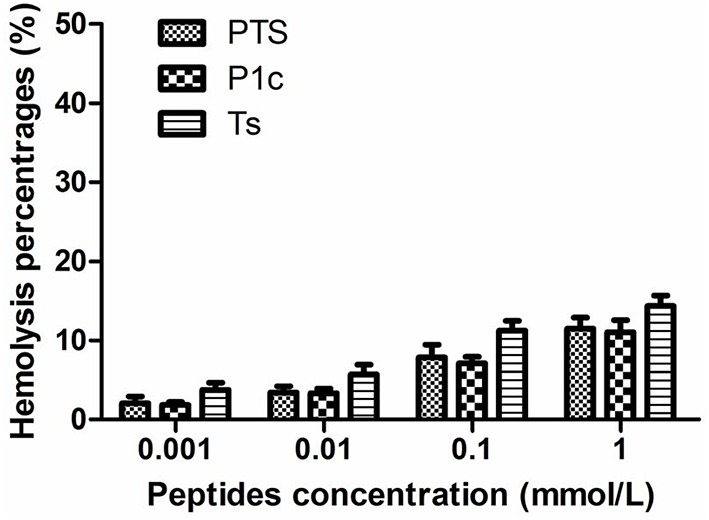
Hemolytic toxicity of PTS, P1c, and Ts. Human erythrocytes were incubated in phosphate buffer with various concentrations of peptides at 37°C for 15 min. There was no significant difference between three groups at tested concentrations (P > 0.05).